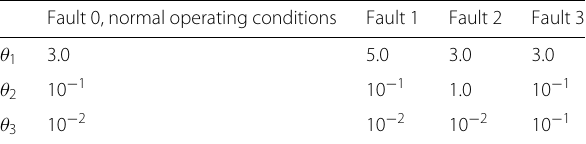
Table 2 Parameters corresponding to normal operation and faulty conditions of oscillator (46)